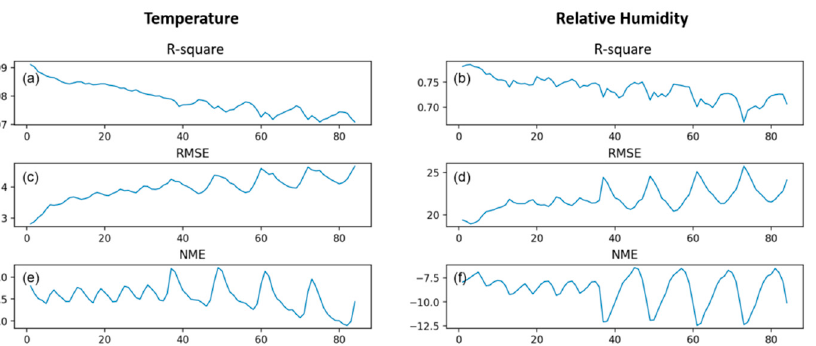
Figure 5. Forecast performance along the forecast lead hours at station 51359; panels ( a , c , e ) are, respectively, referring to the R-square, RMSE, and NME values of temperature. The panels ( b , d , f ) are the metric values of relative humidity. The x -axis refers to forecast lead time.